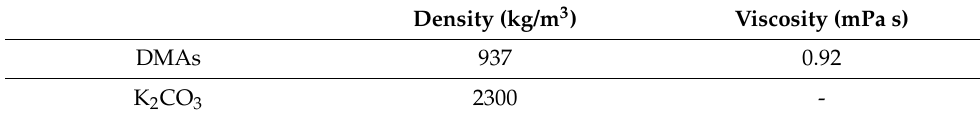
Table 4. Density and viscosity of solvent (DMAs) and dispersant (K 2 CO 3 ).